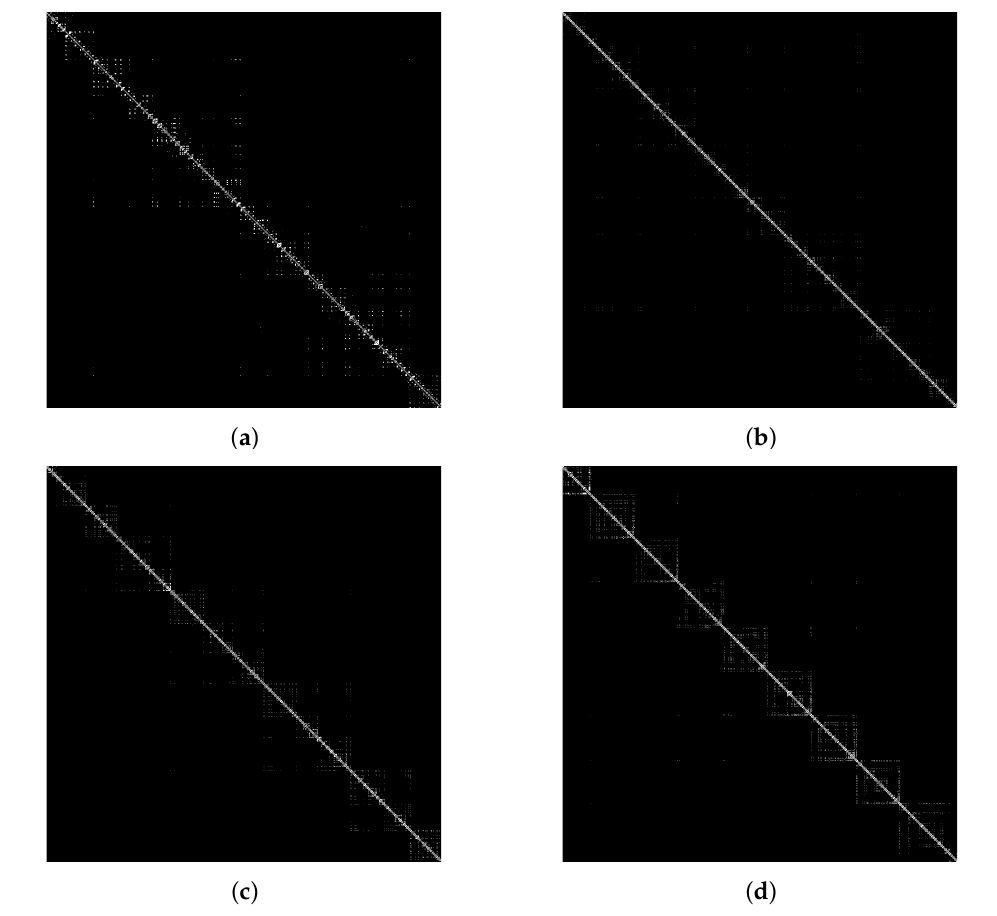
Figure 5. VGAM from vibration signals. (a) NM; (b) RB; (c) IR; (d)